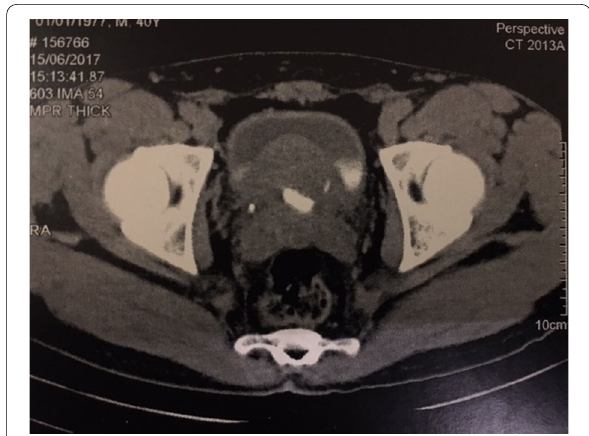
Fig. 3 Pelvic CT scan showing the prostatic hypertrophy and a seminal vesicle